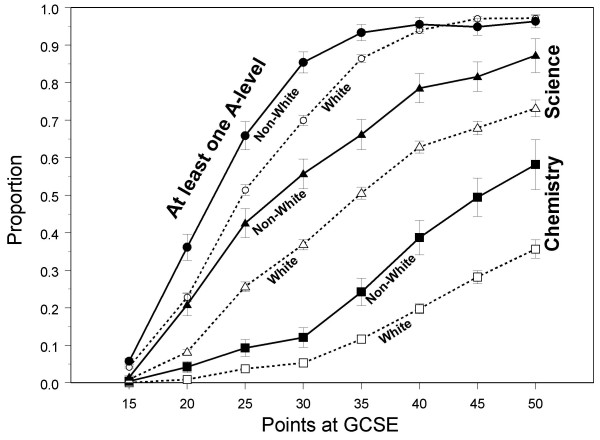
Proportion of W (Open points and solid lines) and NW students (solid points and dashed lines) taking at least one A-level (circles), at least one science A-level (triangles), and chemistry A-level (squares), in relation to points gained at GCSE. Error bars show ± one standard error.